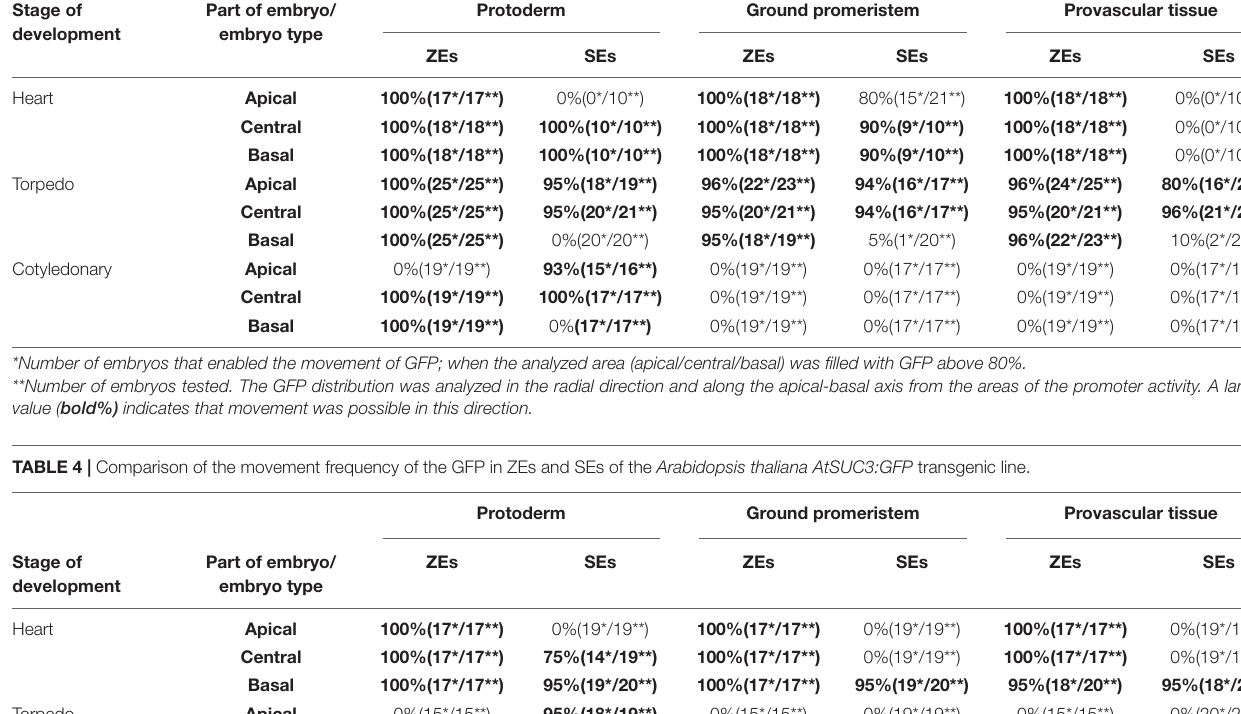
TABLE 3 | Comparison of the movement frequency of the GFP in the SEs and ZEs of the Arabidopsis thaliana AtGL2:GFP transgenic line. Stage of development